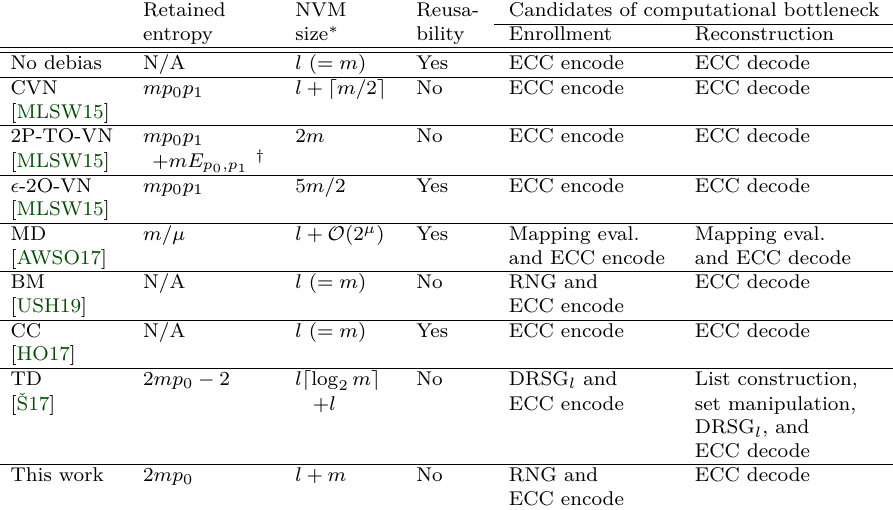
Table 3: Comparison of implementation costs for binary